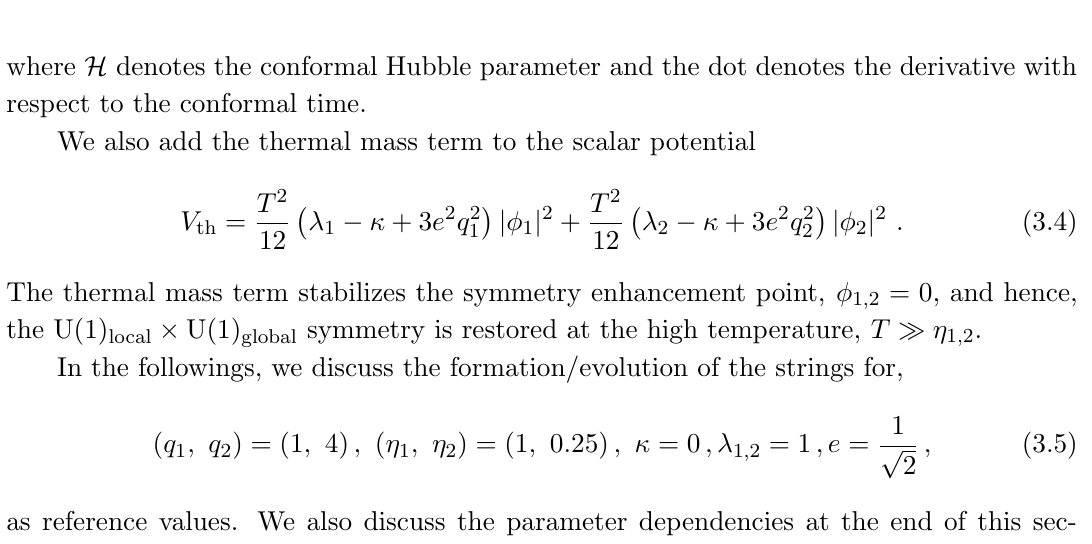
Table 1. Simulation parameters. H in and H (cid:12)n are the Hubble parameter at the initial time and the (cid:12)nal time,